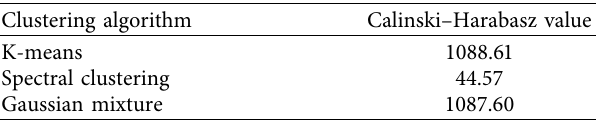
Figure 2: Optimal number of clusters with the elbow method for Scenario 1. Table 3: Calinski–Harabasz values for different clustering algorithms for Scenario